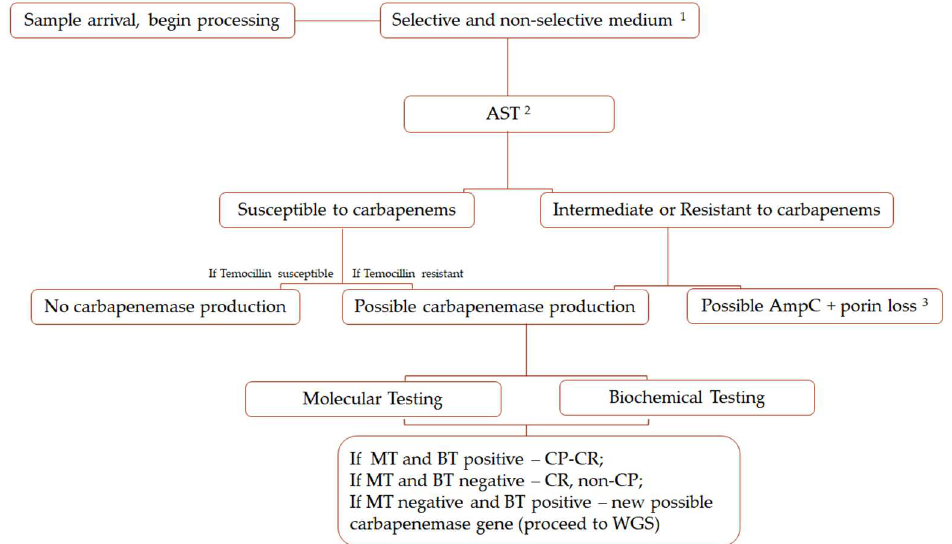
Figure 2. Suggested diagnostic routine for carbapenemase detection. AST, antimicrobial susceptibility testing; BT, biochemical testing; CP, carbapenemases-producing; CR, carbapenem resistant; MT, molecular testing; WGS, whole genome sequencing. 1 If possible, include commercially available selective media to carbapenemase-producing Enterobacterales. 2 AST including meropenem (10 µg) and/or imipenem (10 µg) plus temocillin (30 µg). 3 May be identified as described in Section 4.3.